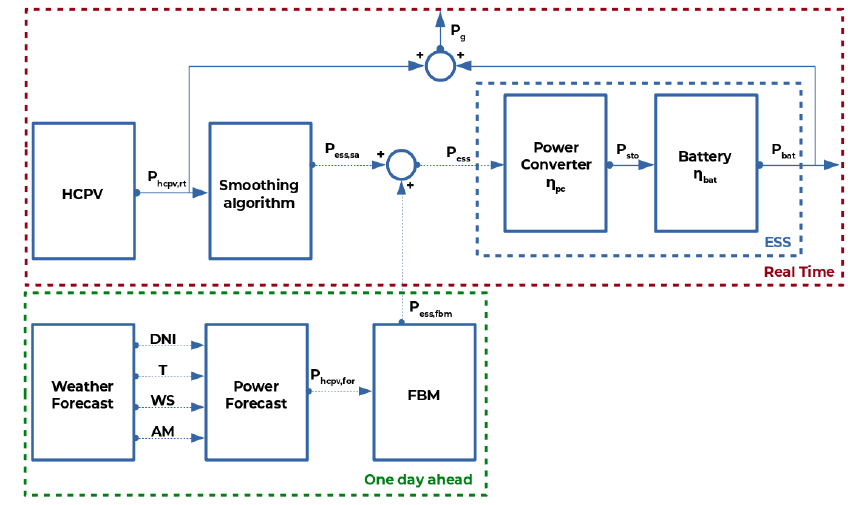
Figure 1. Block scheme of the procedure presented in this